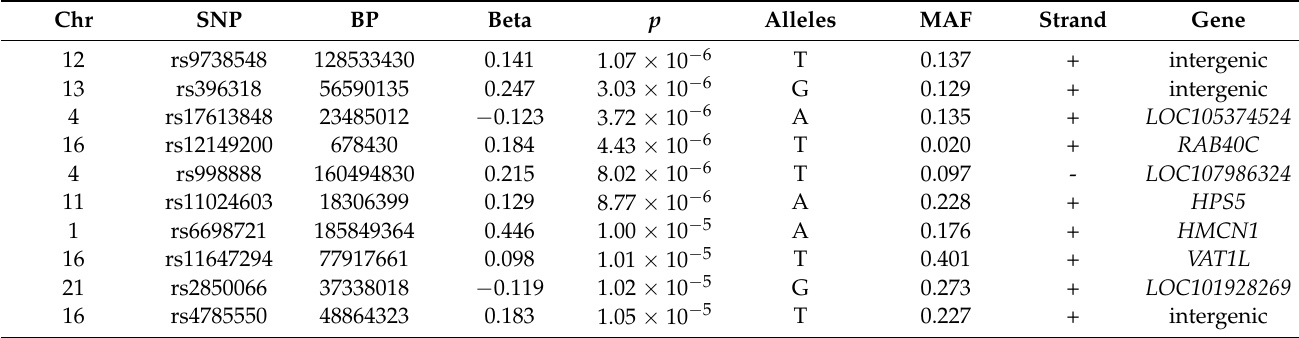
Table 5. Top-ranked SNPs in the genome-wide association study (GWAS) for adiponectin concentrations (ln-transformed) in the whole population.